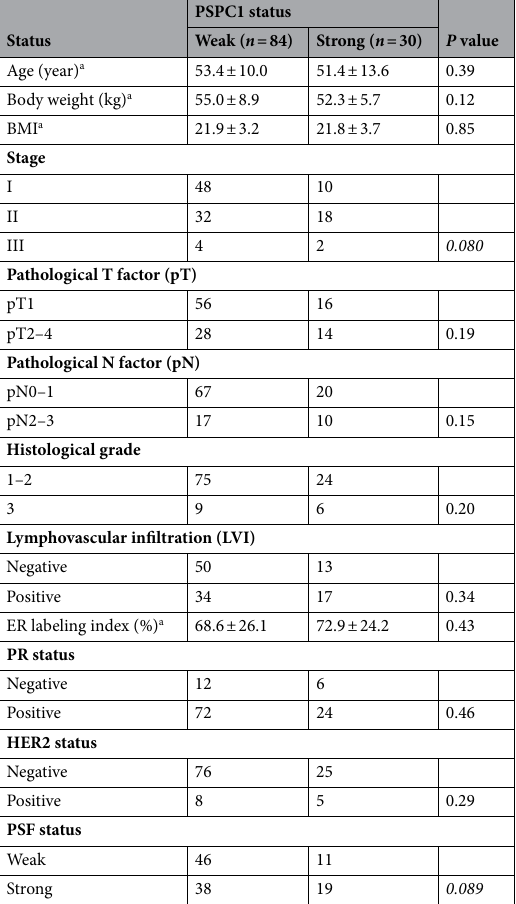
(Fig. 2G,H). The qRT-PCR analysis with primer sets for ESR1 and SCFD2 mRNAs demonstrated that PSPC1-spe- cific siRNAs substantially repressed ESR1 and SCFD2 expression compared with control siRNA (Fig. 2I,K,M,O). However, qRT-PCR with another primer set for intron reveals that PSPC1-specific siRNAs increased or had no effect on intron-containing pre-mRNAs of ESR1 and SCFD2 , implicating a discordant effect on pre-mRNA maturation or splicing (Fig. 2J,L,N,P). We further performed siRNA-mediated double knockdown experiments for PSPC1/PSF. While PSPC1 single knockdown significantly impaired MCF-7 and OHTR cell proliferation, double knockdown of PSPC1/PSF markedly suppressed cell proliferation (Supplementary Fig. S1), suggesting possible cooperative functions of PSPC1 with PSF. SCFD2 is associated with poor prognosis for ER‑positive breast cancer patients. We demon- strated that SCFD2 mRNA levels were associated with poor prognosis for ER-positive breast cancer patients using Kaplan–Meier plotter database in the previous study 12 . Immunohistochemical analysis was performed to reveal the role of SCFD2 protein in clinical samples, and SCFD2 IR was strong in 45 cases whereas weak in 69 cases among the present 114 cases (Fig. 3A,B). Normal mammary tissues showed weak or negligible SCFD2 IR (Fig. 3C). SCFD2 status was positively correlated with histological grade, PSF status, and HER2 status, and had